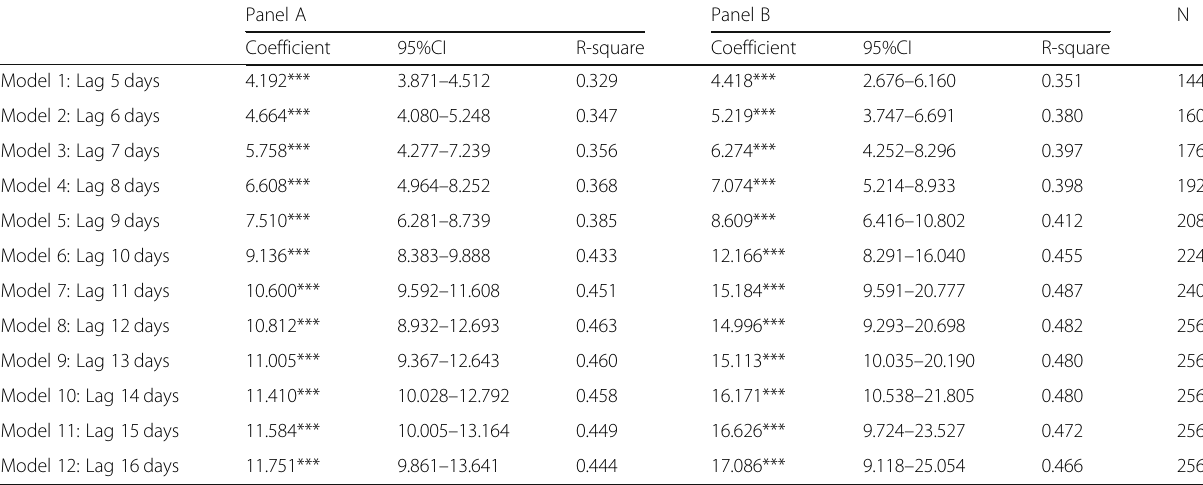
Table 2 Population mobility and number of confirmed COVID-19 cases: based on RE model Panel A Panel B